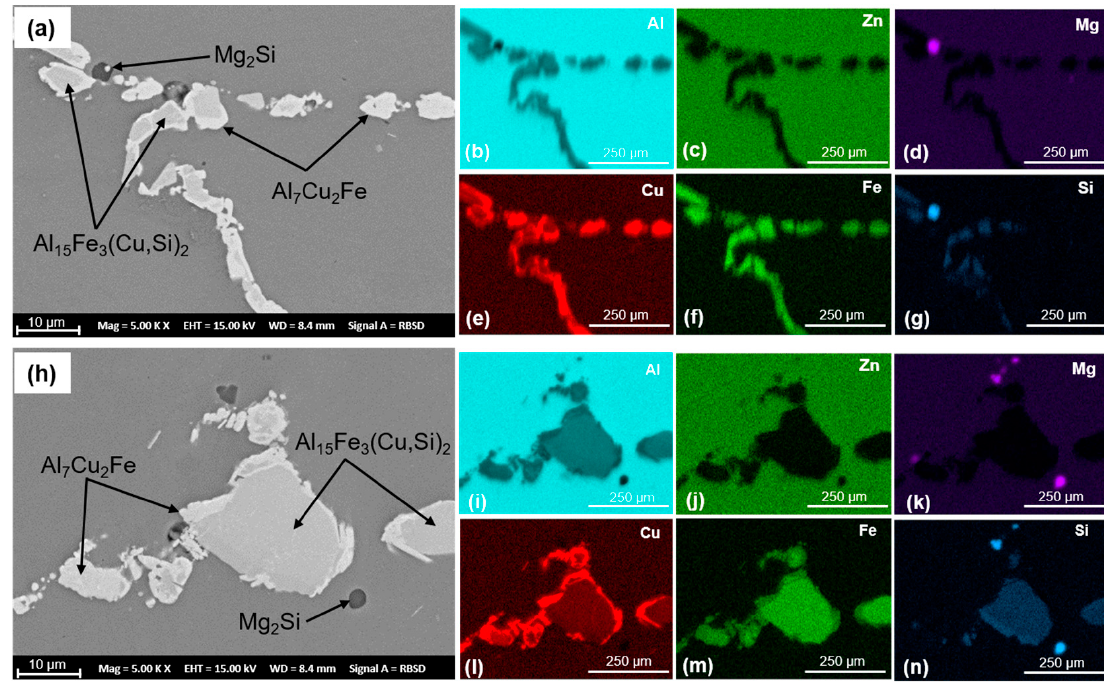
Figure 4. Coarse primary phases present in the alloys after processing to T4 state and the corresponding EDX maps for 7449 ( a – g ) and 7449+Cr ( h – n ).